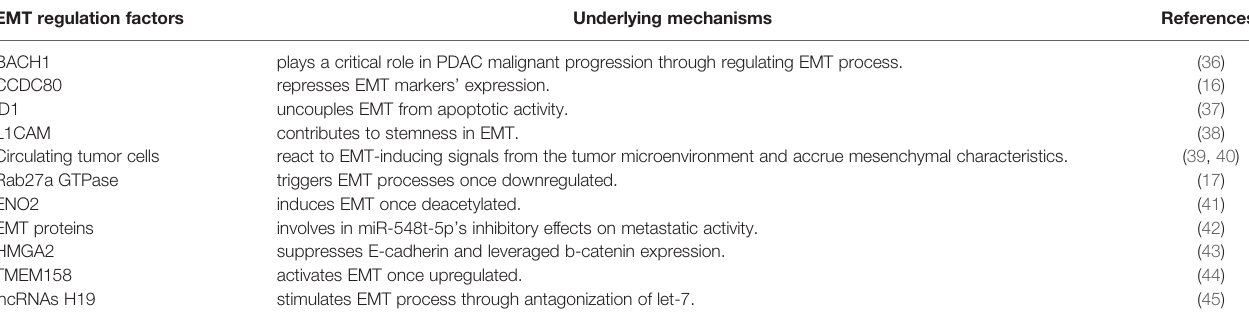
TABLE 1 | EMT regulation factors involved in pancreatic cancer progression and